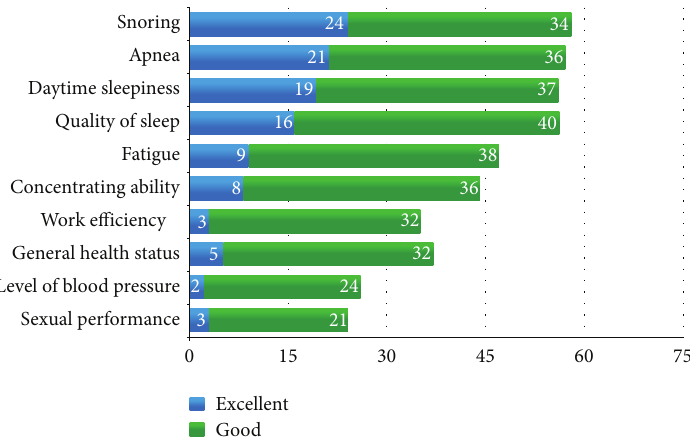
Figure 4: Symptoms which improved after PAP